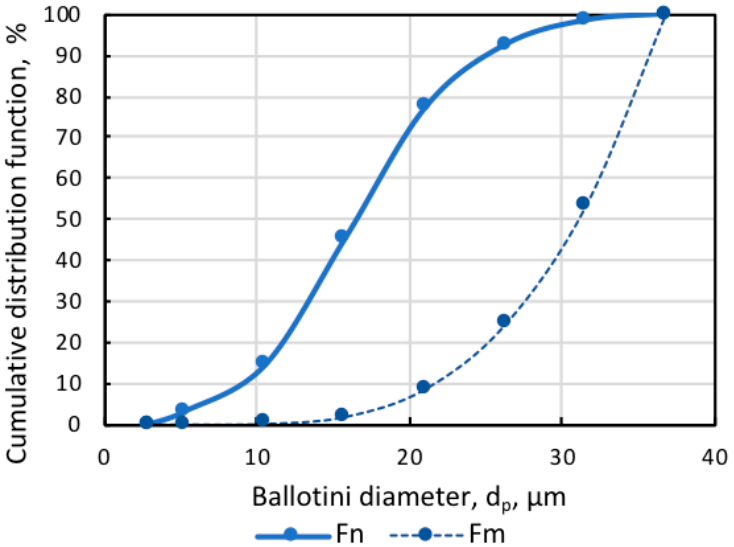
Figure 2. Numerical F n and mass F m cumulative distribution functions of Ballotini.